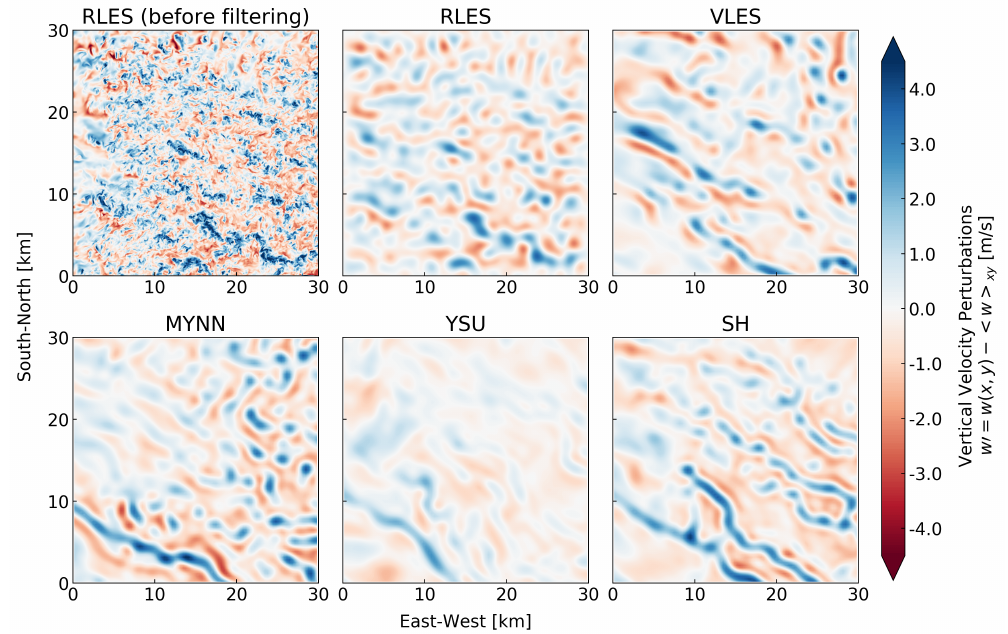
Figure 11. Contours of vertical velocity perturbations at z / z i = 0.5 for all simulation strategies on 28 March, 20:10 UTC (14:10 LT). This is the last time considered in the analysis of 28 March, as determined by the − z i / L convective regime categorization. For completeness, RLES is shown before and after spatial